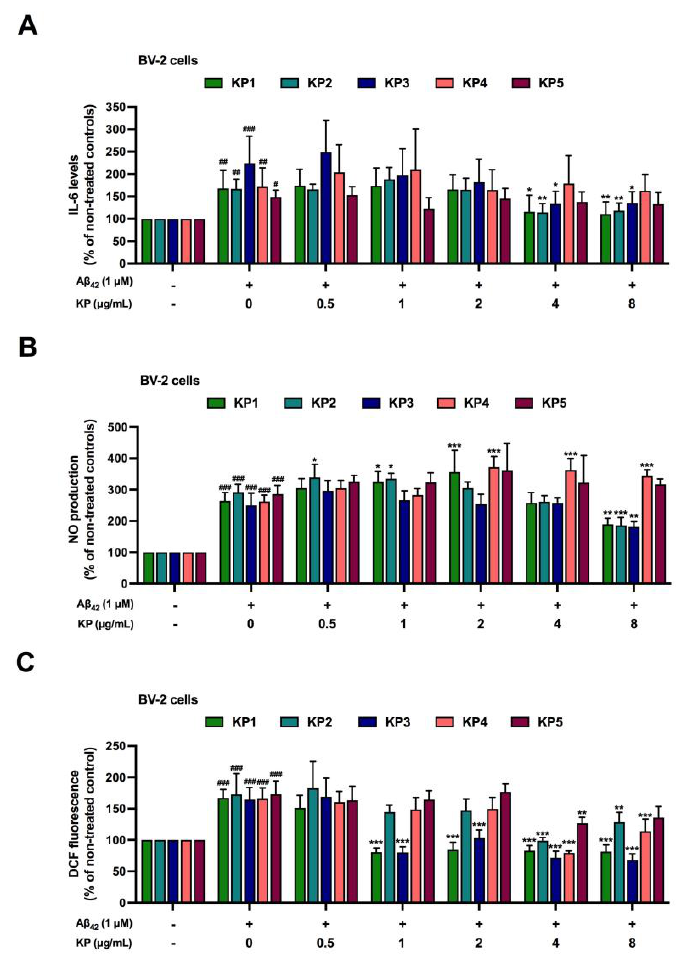
Figure 4. Anti-inflammatory and antioxidant effects of five K. parviflora fractions on A β 42 -induced neurotoxicity in monoculture of BV-2 cells. ( A ) IL-6 levels, ( B ) nitric oxide (NO) production, and ( C ) DCF fluorescence. Values are mean ± SD of three independent experiments. The # shows a significant difference between the control and cells exposed to A β 42 peptides without KP extract using one-way ANOVA followed by Tukey’s test. # , p < 0.05, ## , p < 0.01, ### , p < 0.001. The * shows a significant difference between cells exposed to A β 42 peptides without KP extract compared to cells exposed to A β 42 peptides and various concentrations of KP extract (0.5–8 µ g/mL) using one-way ANOVA followed by Tukey’s test. *, p < 0.05, **, p < 0.01, ***, p < 0.001.